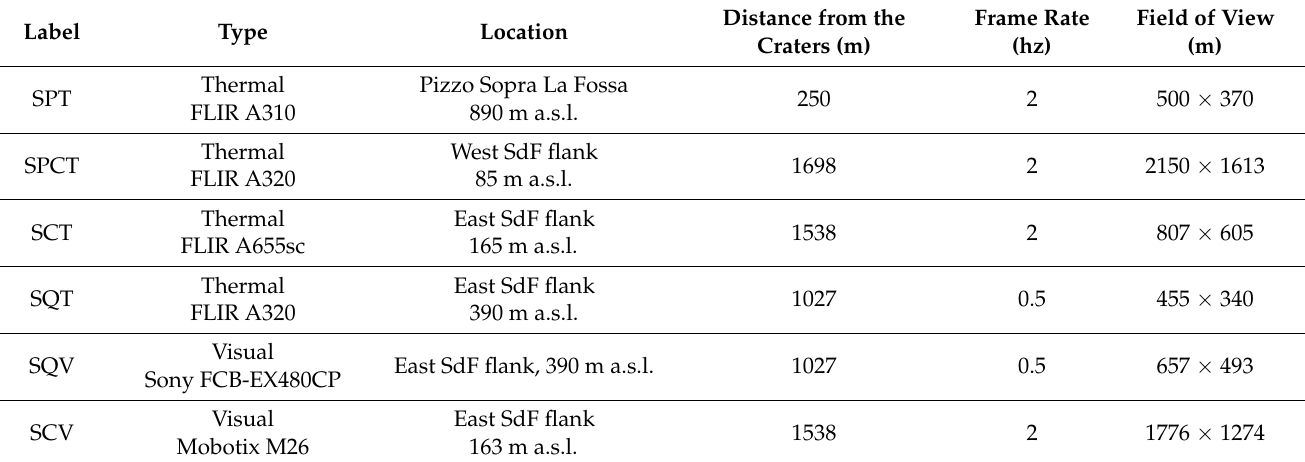
Table 1. List of the INGV monitoring cameras and of their main features. SdF = Sciara del Fuoco. The field of view is considered at the crater